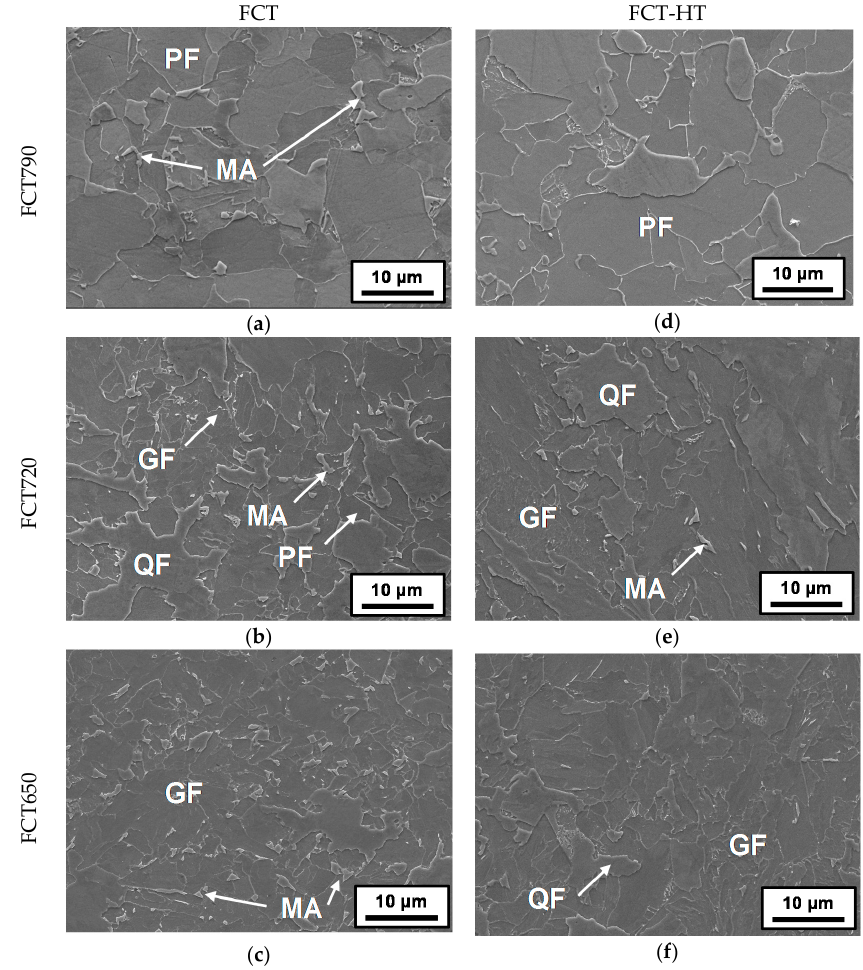
Figure 5. FEGSEM (field-emission gun scanning electron microscopy) micrographs corresponding to every Fast Cooling Temperature and both ( a – c ) FCT and ( d – f ) FCT-HT samples: ( a , d ) FCT790, ( b , e ) FCT720 and ( c , f )